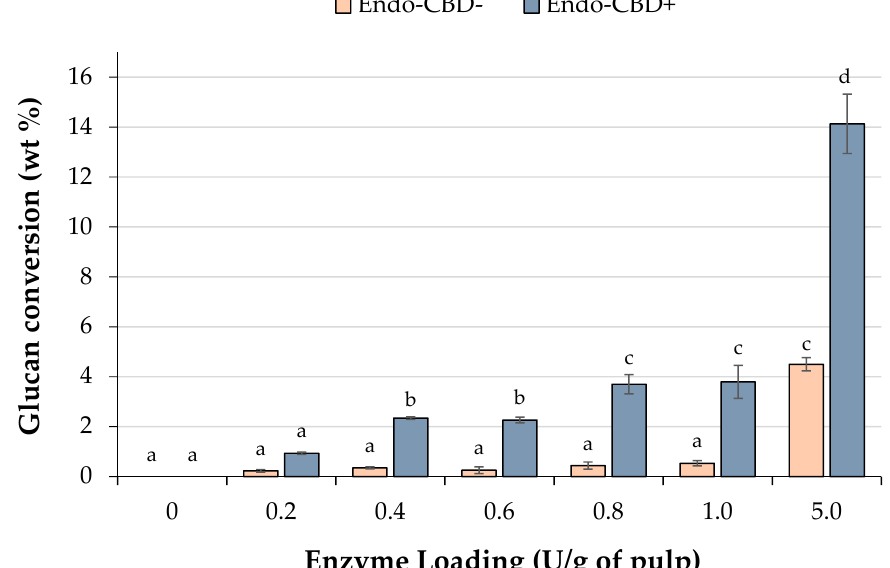
Figure 1. Glucan conversion from hydrolysis of wood pulp with endoglucanases. Wood pulp was subjected to enzyme hydrolysis at various loadings of endoglucanases with (Endo-CBD+) or without (Endo-CBD − ) a cellulose-binding domain. Since endoglucanases generate long/short chain sugars rather than monosaccharides (i.e., glucose), quantification of the sugars released from wood pulp into the supernatant through endoglucanase action was achieved through a secondary enzymatic hydrolysis that enabled complete hydrolysis of sugars to glucose monomers. Columns labelled with different letters indicate means that are statistically different at a 95% confidence